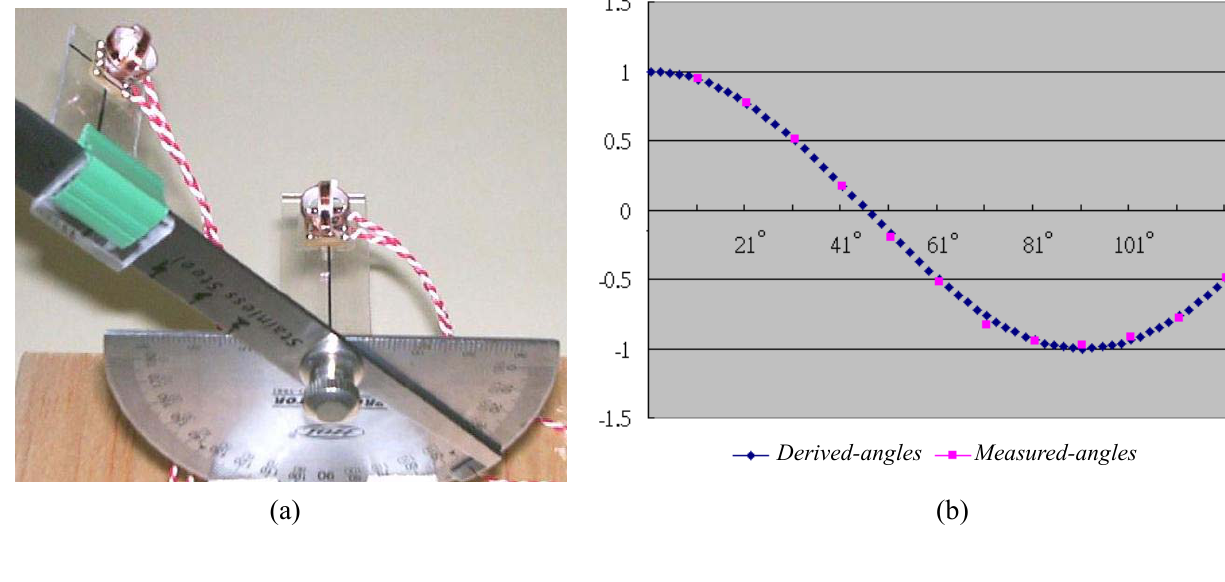
Figure 8. Illustration of a bending angle experiment: (a) the bending angle measurement device; (b) the derived angles versus the measured angles in the bending angle